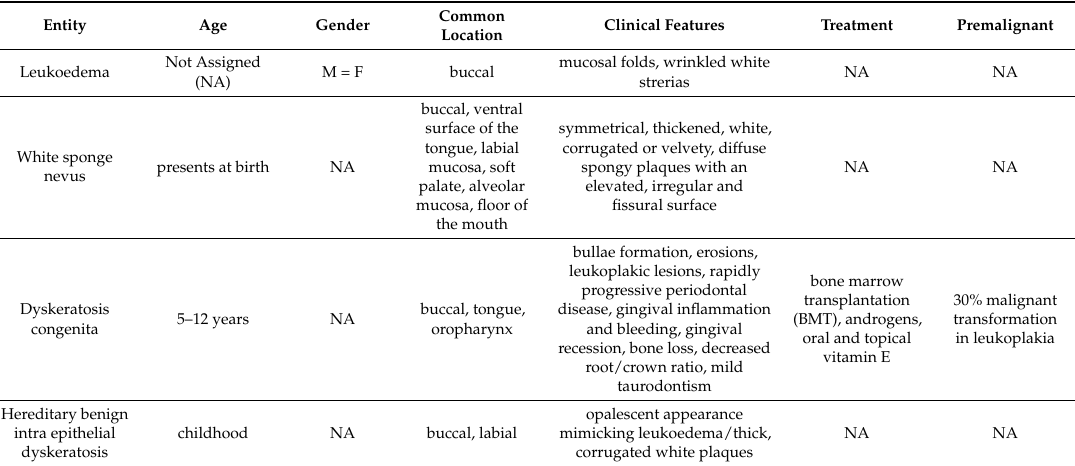
Table 1. Characteristics of congenital/genetically white